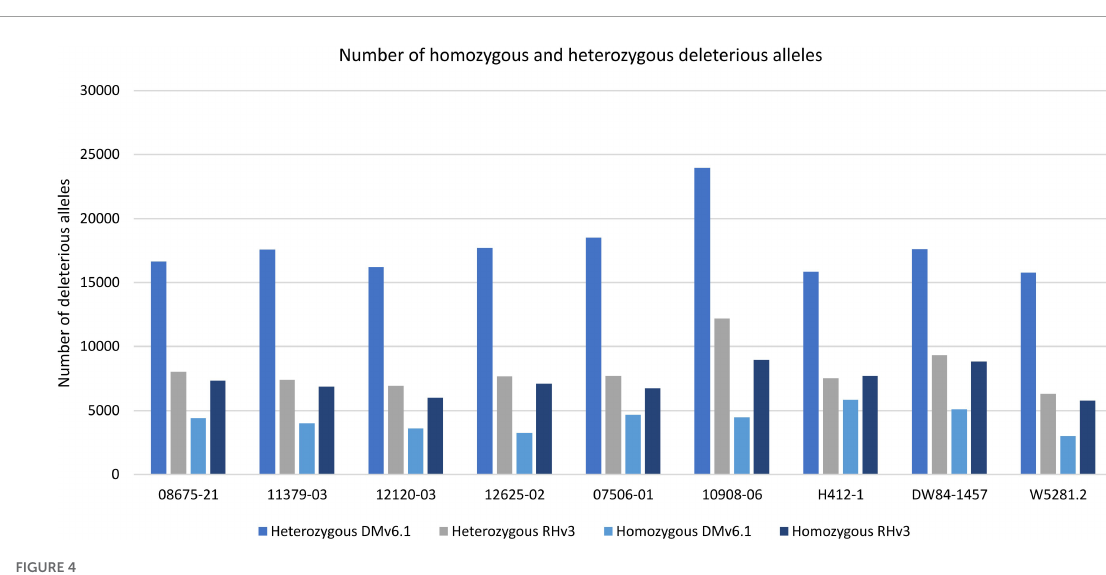
StCDF1 loci Contigs from the genome sequence of the diploid clones were aligned to StCDF1.1 from DMv6.1 and it was